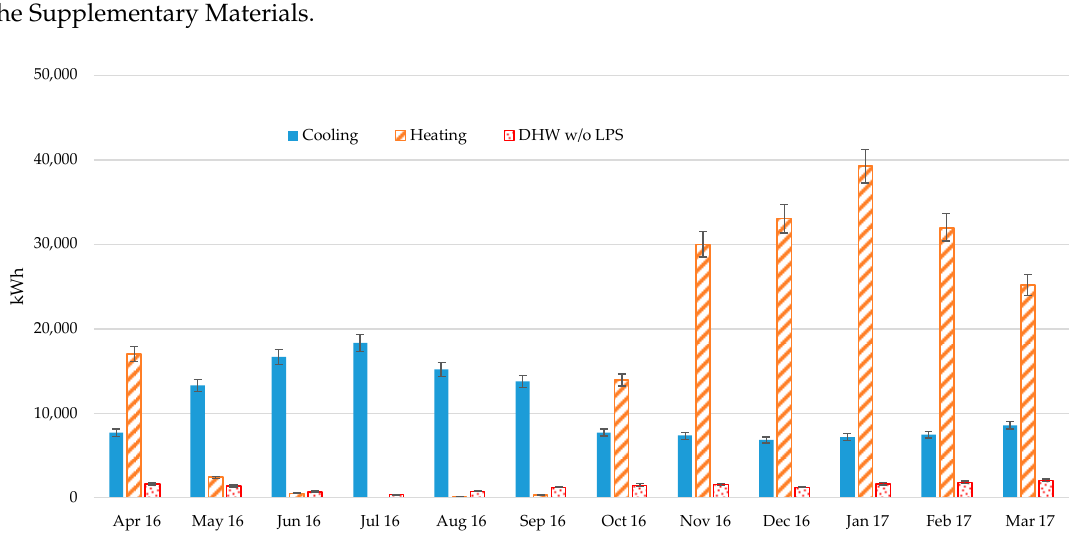
Figure 3. Monthly heating, cooling, and domestic hot water (DHW) load (not including Legionella protection energy) with uncertainty bars. 1 April 2016 ‒ 31 March 2017.